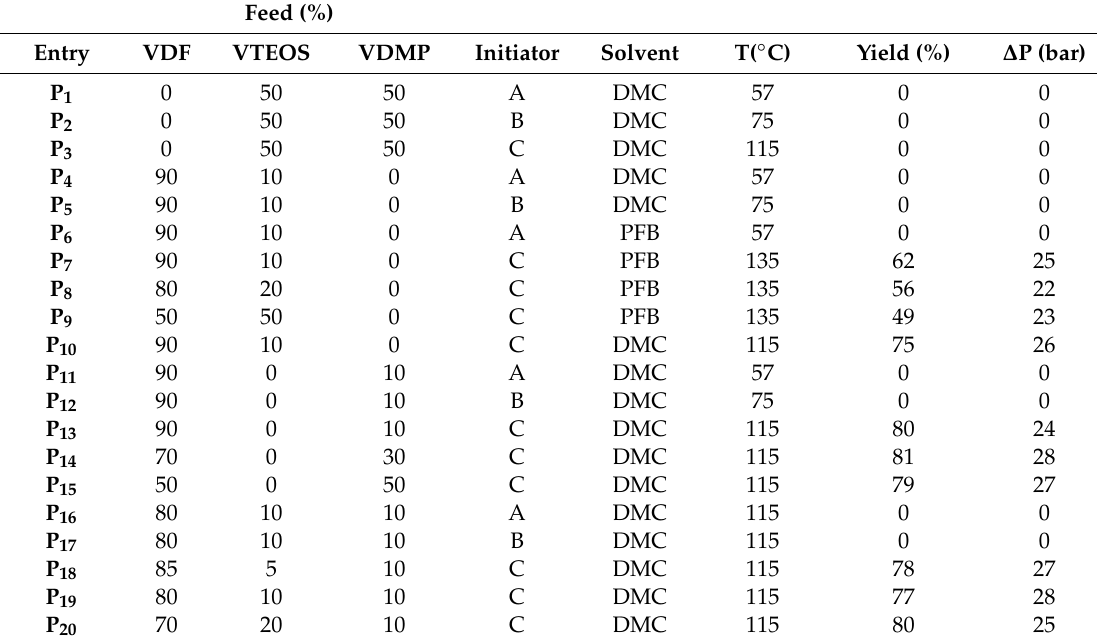
Table 1. Experimental conditions of the radical terpolymerization of VDF with VTEOS and VDMP and